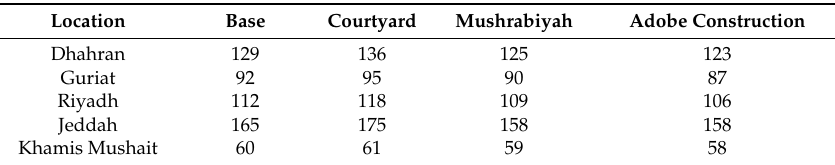
Table 6. The annual electricity demand in kWh/m 2